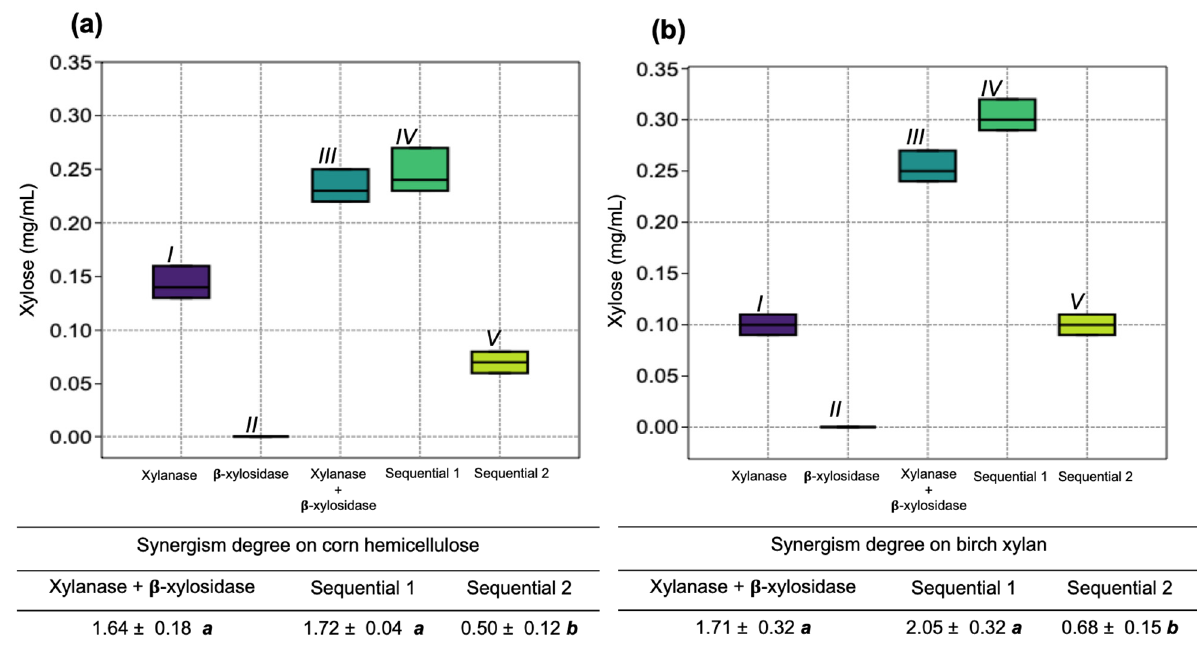
Figure 6. Xylose release and degree of synergism between xylanase SRXL1 and β -xylosidase SRBX1 activity from S. reilianum in the degradation of corn hemicellulose ( a ) and birch xylan ( b ). Sequence 1: xylanase was added first, followed by β -xylosidase. Sequence 2: β -xylosidase was added first, followed by xylanase. Amounts of 0.5 and 2.0 U of xylanase and the β -xylosidase were used, respectively. The same numbers roman indicates that no statistically significant difference was observed; p < 0.05.